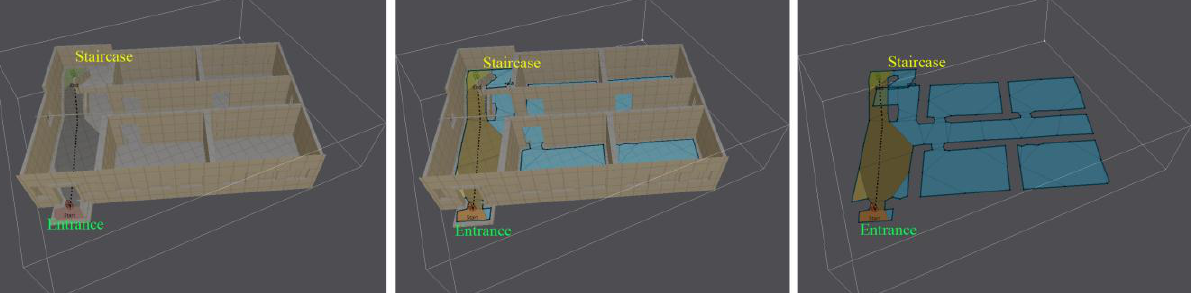
Figure 7 Navigation route from Entrance to Staircase